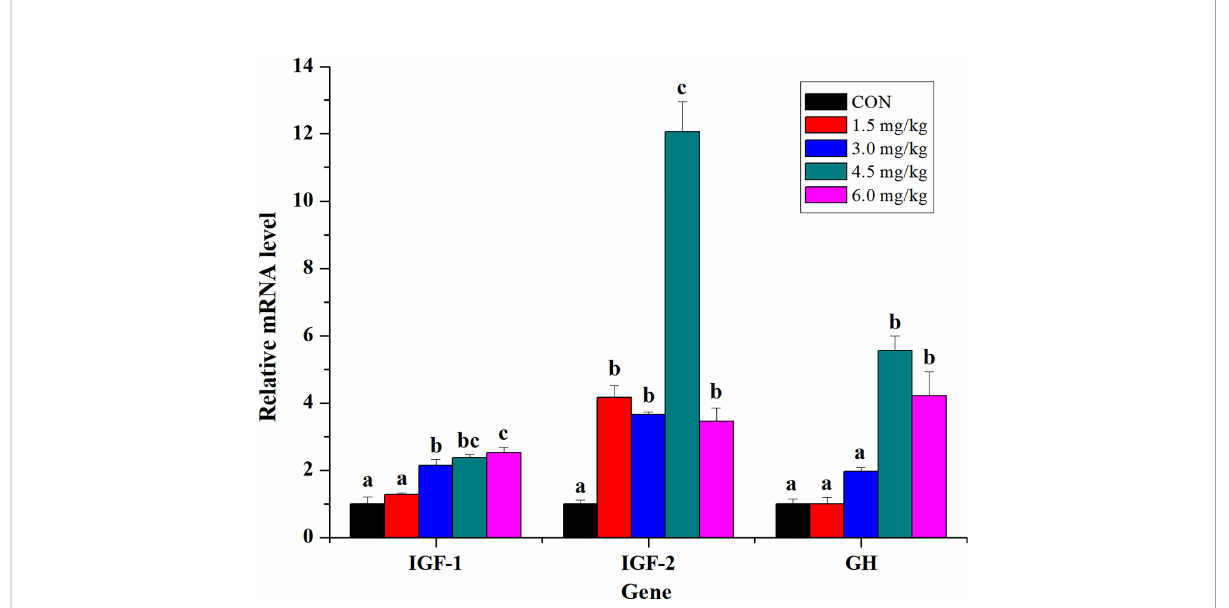
FIGURE 2 Effects of PQQ on the gene expression of growth-related genes GH , IGF-1 , and IGF-2 in the liver of yellow cat fi sh. Bars with different letters in the same gene indicate signi fi cant difference between the corresponding treatment (P < 0.05) (n = 3).